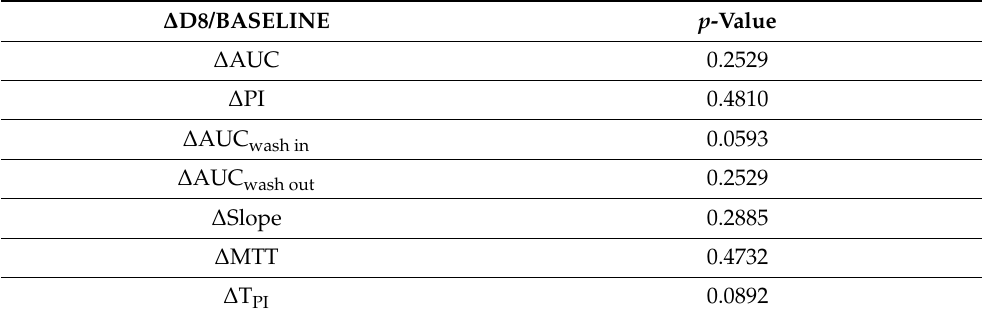
Table 2. Significance level ( p -value) of the association between changes in perfusion parameters values between baseline and D8 and overall